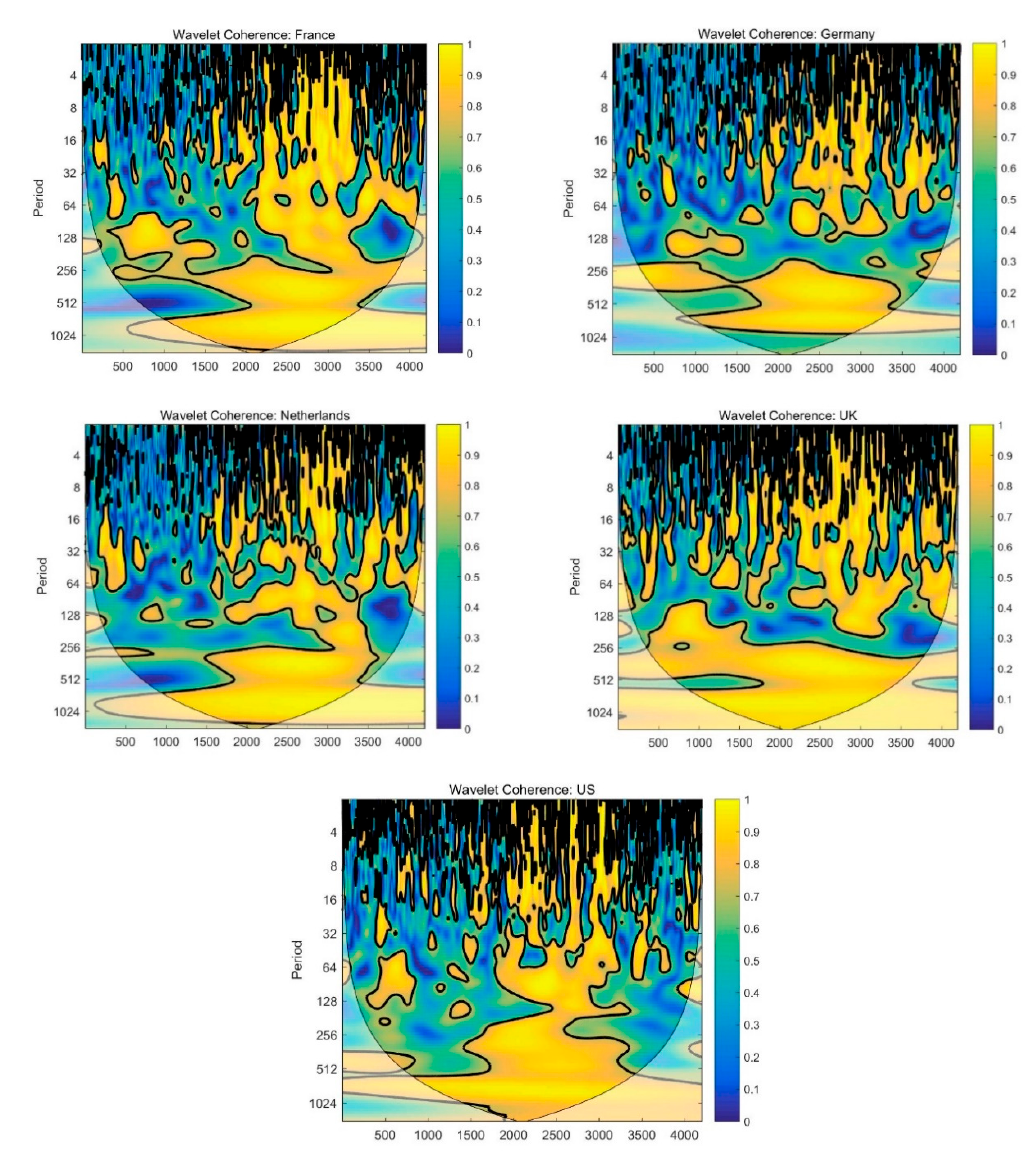
Figure 2. Wavelet coherence between securitized real estate and local stock markets. Notes: Contours are for wavelet coherence. The color bar on the right-hand side of each graph range from low coherency (dark blue color) to high coherency (yellow color). The thick dark lines indicate the 5% significant level for wavelet coherence. The arrows indicate the phase difference, which can determine the lead–lag relationship between the series.